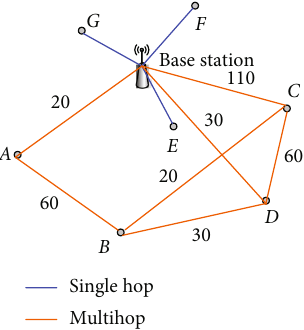
Figure 8: Improved Dijkstra